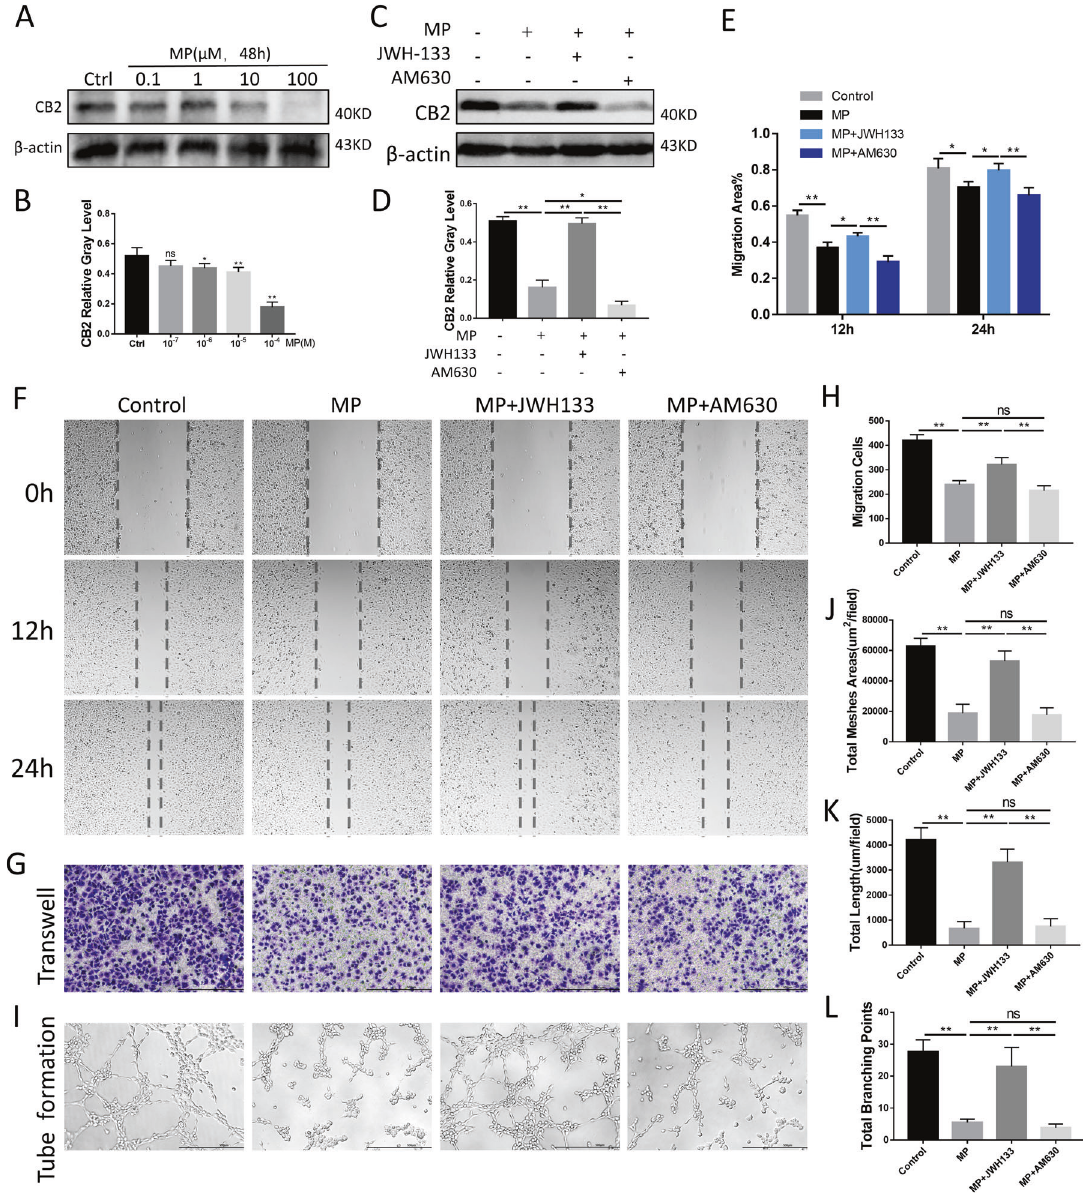
Fig. 8 Angiogenesis was promoted by CB2 under MP intervention in vitro. A , B CB2 expression under different concentration of MP for 48 h. C , D Expression of CB2 under MP, JWH133, and AM630 intervention. E , F Scratch assay for 0, 12, and 24 h. G , H Transwell assay, and migration cells. I – L Tube formation and quantitative analysis ( n = 3 per group, data are shown as mean ± SD, * p < 0.05; ** p < 0.01; ns, not signi fi